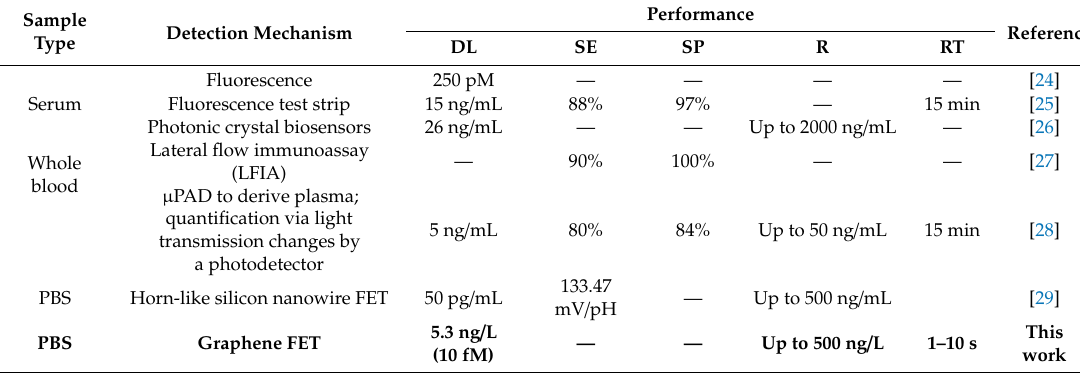
Table 2. Ferritin-targeted micronutrient